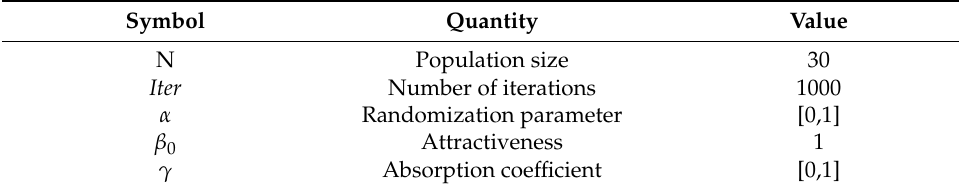
Table 2. Parameter settings of FA and